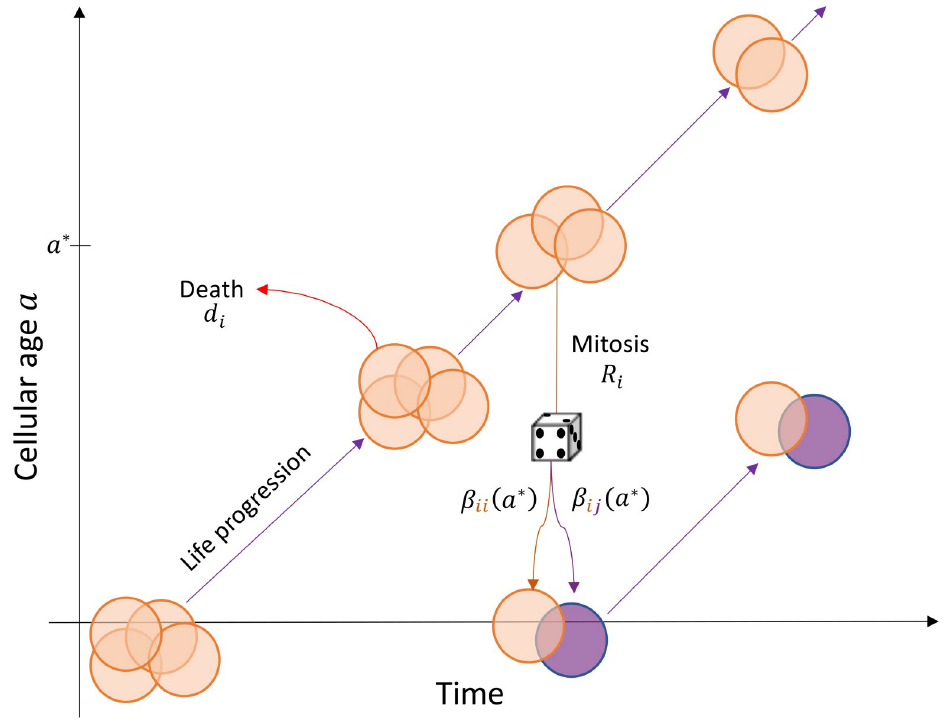
Fig 1. Schematic of the age structured PDE model (2). The life progression of a cohort of phenotype i cells with chronological time and age on the x and y axis, respectively. These cells are born with age a = 0 and progress through time-age space along the solid lines. The solid lines representing life progression are the characteristic curves of (2). Cells leave the cohort due to death, which occurs at a constant, but phenotype specific, rate d i , or when reproducing at . In the figure, a parental cell with age a � leaves the cohort and reproduces to produce two a phenotype specific rate R i daughter cells with age a = 0. These daughter cells either inherit phenotype i with probability β ii ( a � ) or change ( a � ). In this model formulation, the birth of two daughter cells is modelled as the phenotype with probability β ij boundary condition in (3) and corresponds to the appearance of two new cells with age a = 0.